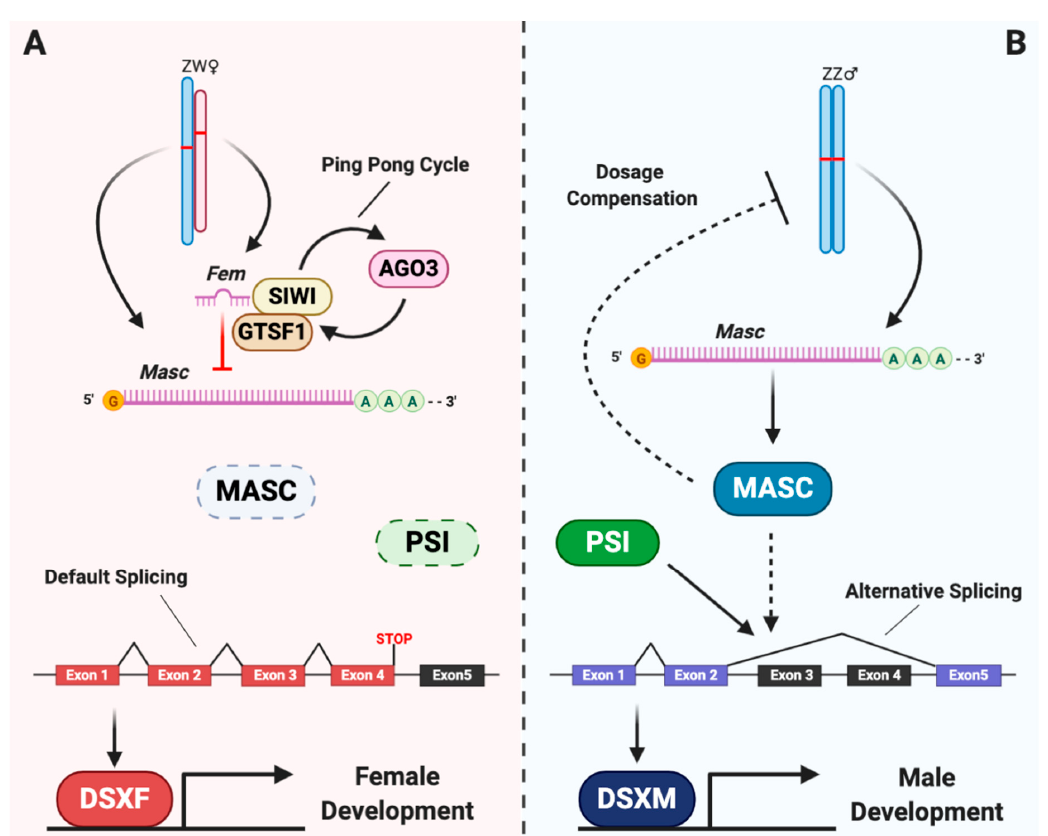
Figure 1. The preliminary established genetic cascade of sex determination in Bombyx mori . Female development is the default sex determination pathway in B. mori ( A ). The Feminizer piRNA ( Fem ) derived from the female W chromosome interacts with the proteins Silkworm-PIWI (SIWI) and gametocyte-specific factor 1 (GTSF1) to form as piRNA-induced silencing complexes and silence Masculinizer ( Masc ) at the mRNA level during ping-pong amplification with Argonaute RISC Catalytic Component 3 (AGO3) [24,25]. The absence of Masc protein (MASC) and an inactive P-element Somatic Inhibitor protein (PSI) results in production of the female-specific isoform of dsx ( dsxF ), which contain all of the exons of the gene [33]. The female-specific DSX (DSXF) results in female morphological sex characteristics [37,38]. MASC is expressed normally in the male due to the lack of Fem and presence of active PSI ( B ), and this results in dosage compensation and splicing that produces the male-specific isoform of dsx ( dsxM ), which contains exons of 1, 2, and 5 of the dsx pre-mRNA [33,36]. The male-specific DSX (DSXM) promotes male development [37,38].